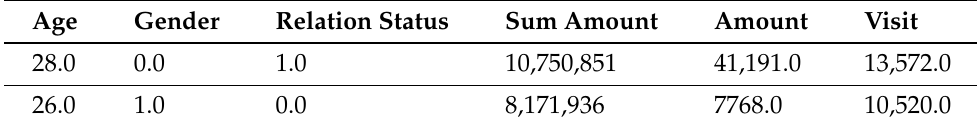
Table 10. Need based Package for Category